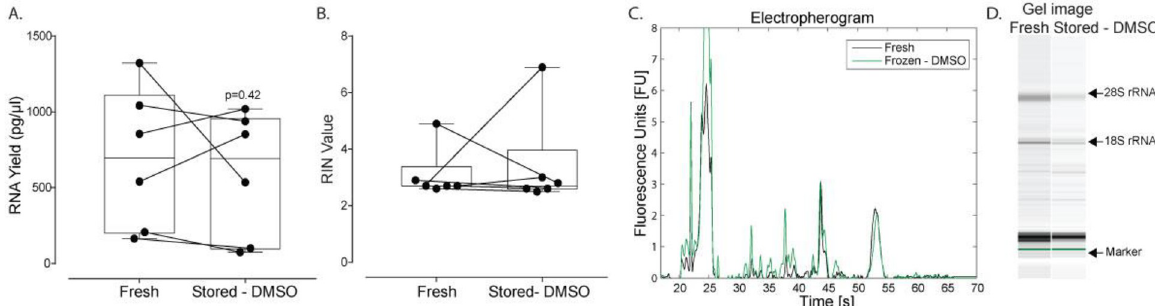
Fig 5. Impact of cryoprotectant agents on RNA yield of plasma-derived EVs. In all cases, cryovials were first placed in a freezing container before adding to the -80˚C freezer and thawed in a warm water bath. RNA was extracted using miRNeasy spin columns. (A) RNA yield and (B) RIN of plasma-derived EVs in stored samples (10–12 days) supplemented with DMSO (10% v/v) versus fresh samples are expressed as box-and- whiskers plots showing median, interquartile range, maxima/minima, and all individual data points (n = 6). (C) A representative electropherogram and (D) gel image showing RNA traces obtained from the Bioanalyzer. Data were analyzed using the Wilcoxon signed-rank test (p < 0.05); an asterisk indicates statistical significance. Fresh (black) versus Stored—DMSO (green) denotes freshly processed versus samples stored in the presence of cryoprotectant agents,